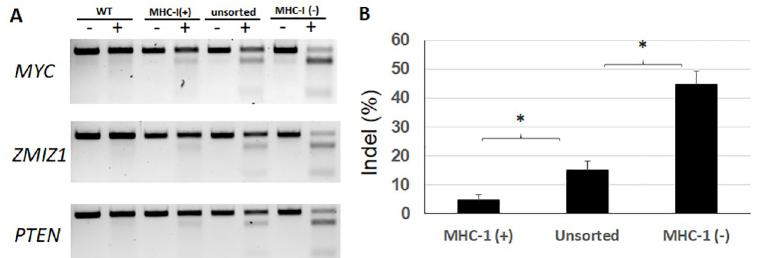
Fig 3. Enrichment of indels with FAME strategy in diverse target genes. A. HEK293T cells were transfected with expression plasmids for spCas9, sgRNAs for B2M and individual genes-of-interest ( MYC , ZMIZ1 and PTEN) . 5 days later, transfected cells were stained with FITC-conjugated antibody against human HLA-A,B&C, sorted into pools of negative and positive cells, and expanded in culture. The pooled cells were amplified for genomic DNA extraction. For each T7EI assay, genomic DNA from 4 samples were included, i.e., wild-type HEK293T cells, MHC-I positive pool, unsorted pool, and MHC-I negative pool. For each sample, both undigested (-) and digested (+) PCR products by T7E1 were run for comparison and quantification. B. Comparison of indel frequencies for MHC-1 (+), unsorted, and MHC-1 (-) cell population. Indel frequencies were calculated using band signal intensity as reported by image analysis of the original gel pictures from the three T7EI assays represented in panel A. Student’s t-test was used to compare the indel frequencies between MHC-1 (+) and unsorted cells, and between unsorted and MHC-1 (-) cells. � p < 0.001.